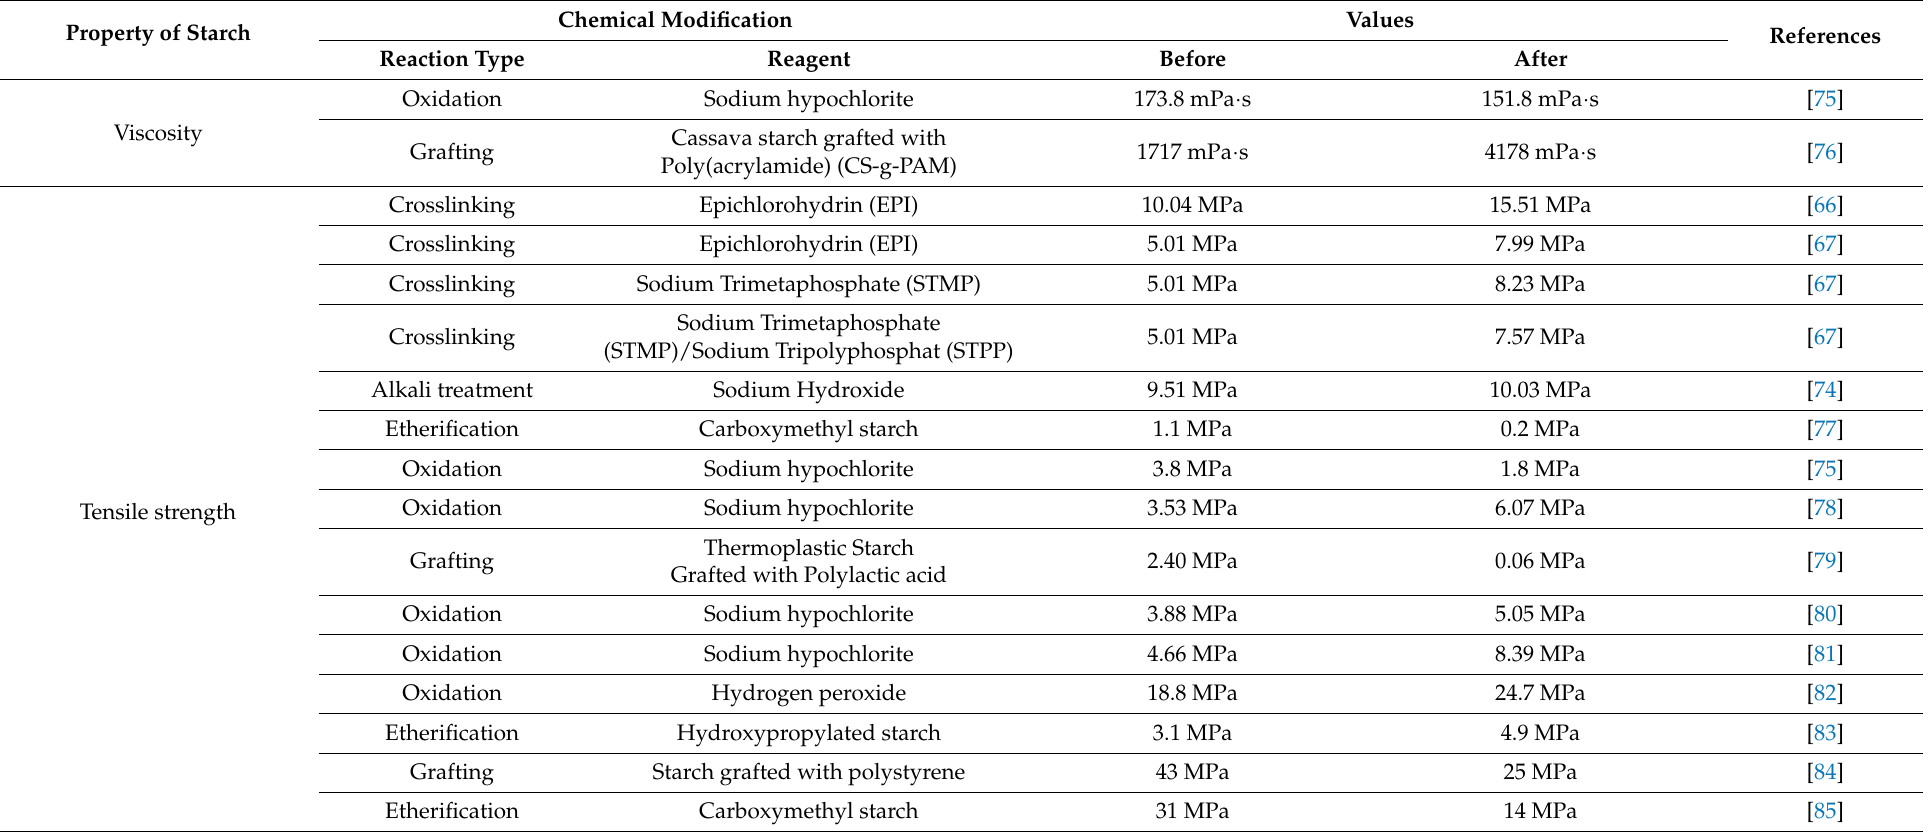
Table 4. Changes in the properties starch upon chemical